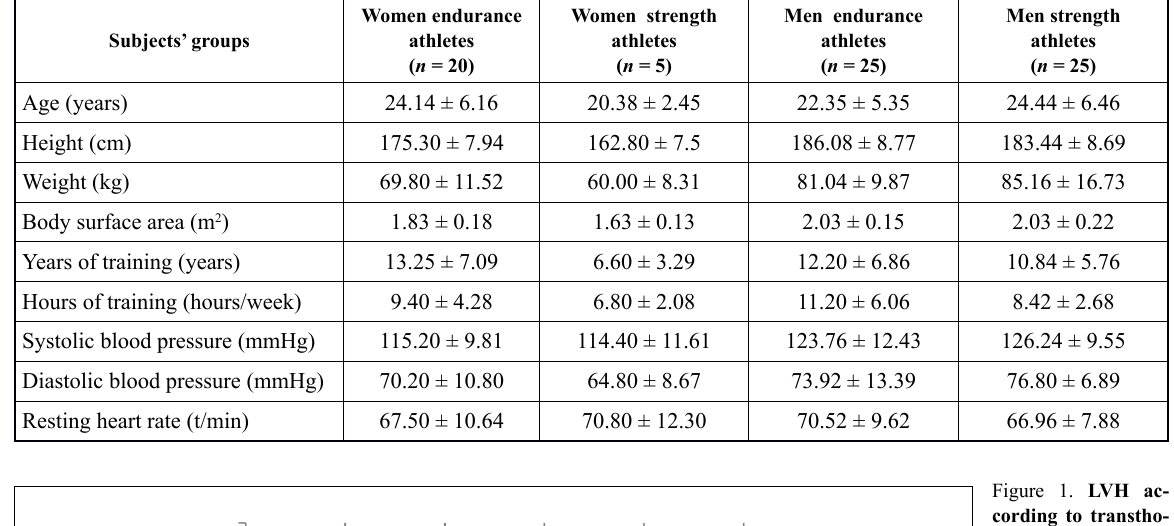
Figure 1. LVH ac - cording to transtho- racic